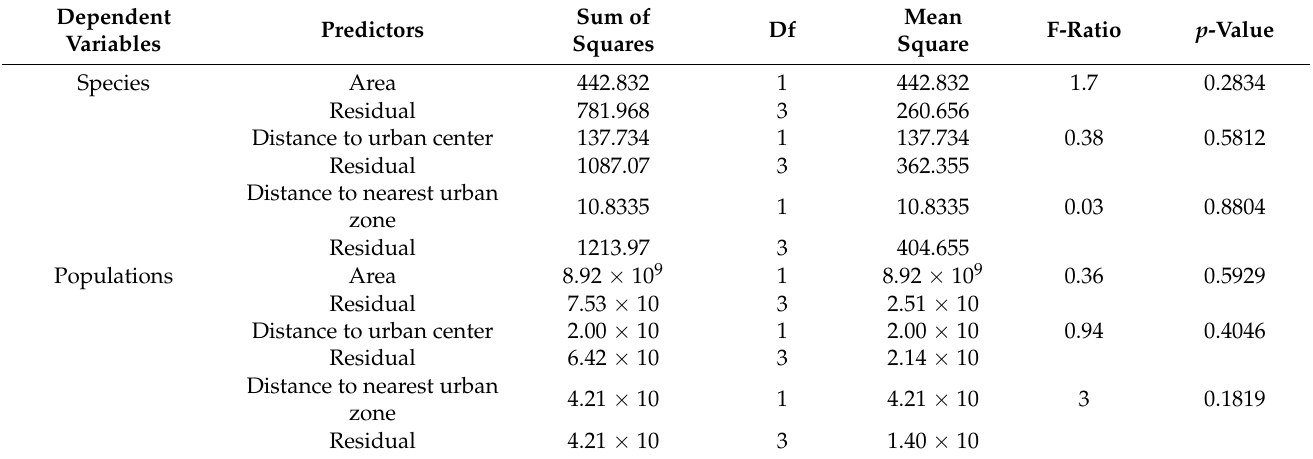
Table 4. Predictors (area, distance to urban center, and distance to nearest urban zone) of diversity (number of species) and abundance of avian species in studied habitats.